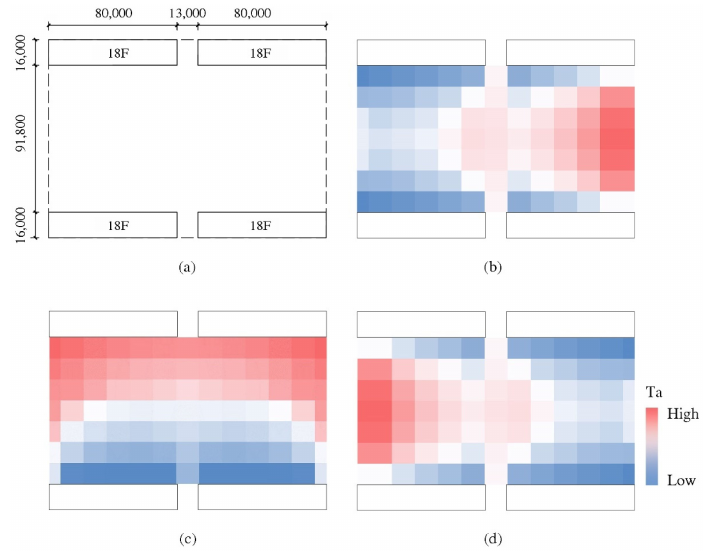
Figure 16. An 18-story parallel group ( a ) and its outdoor air temperature differences at 9:00 ( b ), 12:00 ( c ), 17:00 ( d